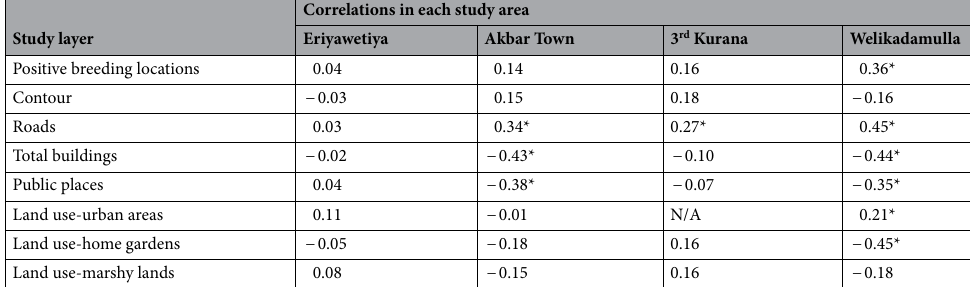
Table 1. Spatial correlations between generated layers with dengue incident location layer in each dengue high risk study area in the multivariate Poisson point process model. *Significantly correlated layers with dengue incidences during the study period. A 5% significance level was used to identify significant correlations. N/A- Urban areas are not included in the land use maps of 3 rd Kurana study area.